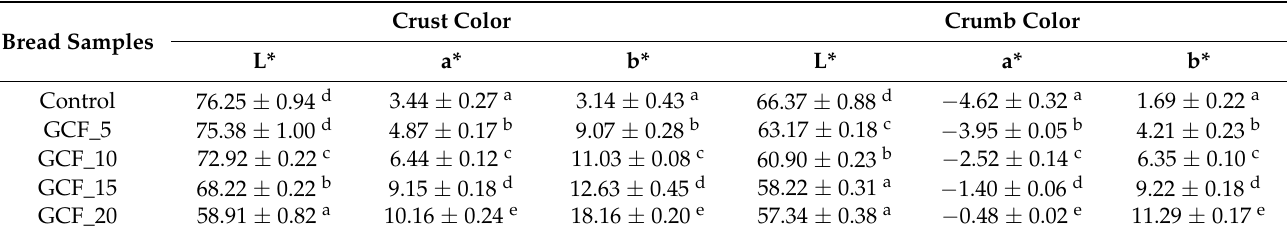
Table 5. Color data of bread samples with different levels of GCF addition in wheat